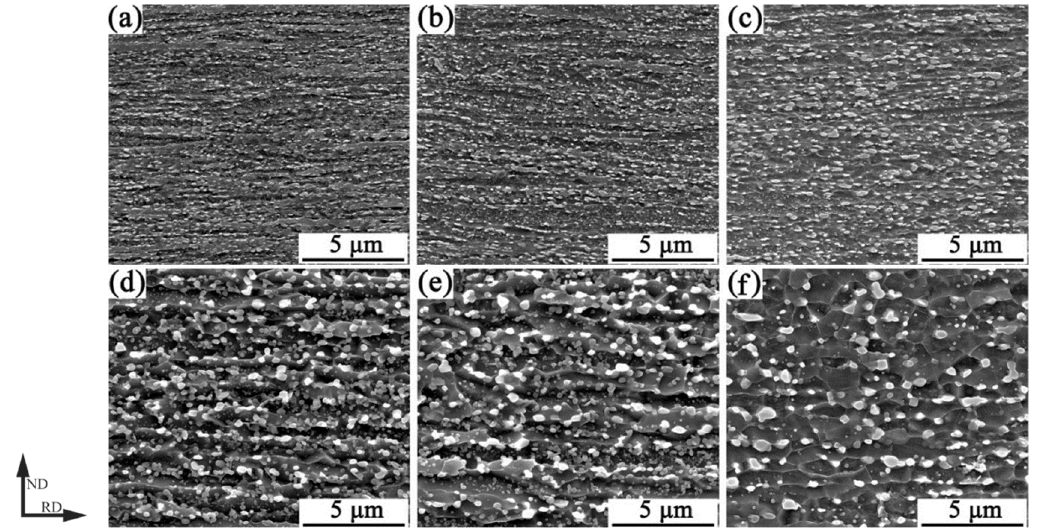
Figure 2. Micrographs of ( a ) 500 °C, ( b ) 550 °C, and ( c ) 600 °C warm rolling and warm rolled at 600 °C annealing at 600 °C for ( d ) 1 h, ( e ) 2 h, and ( f ) 4 h.